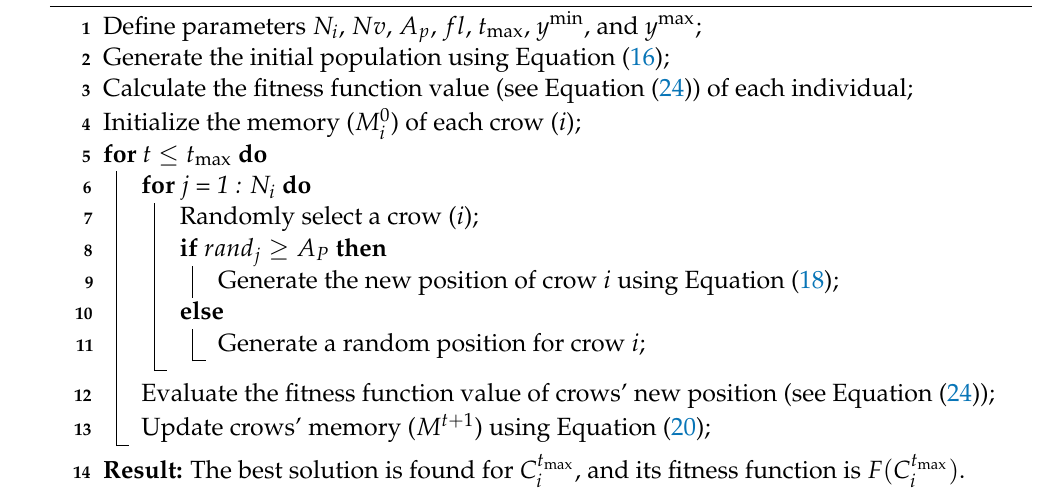
Algorithm 1: Crow search algorithm used to solve optimization